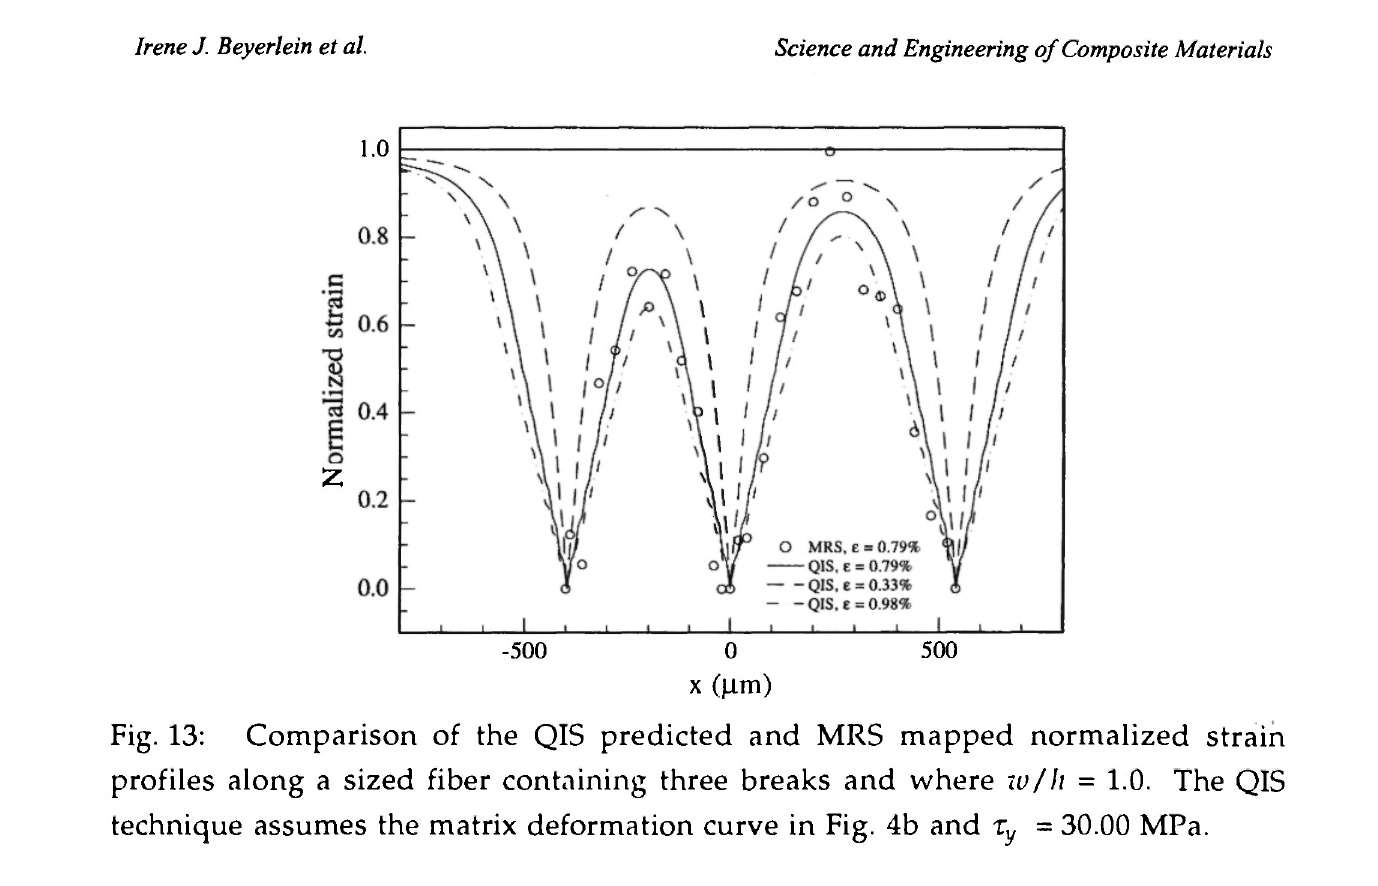
Fig. 13: Comparison of the QIS predicted and MRS mapped normalized